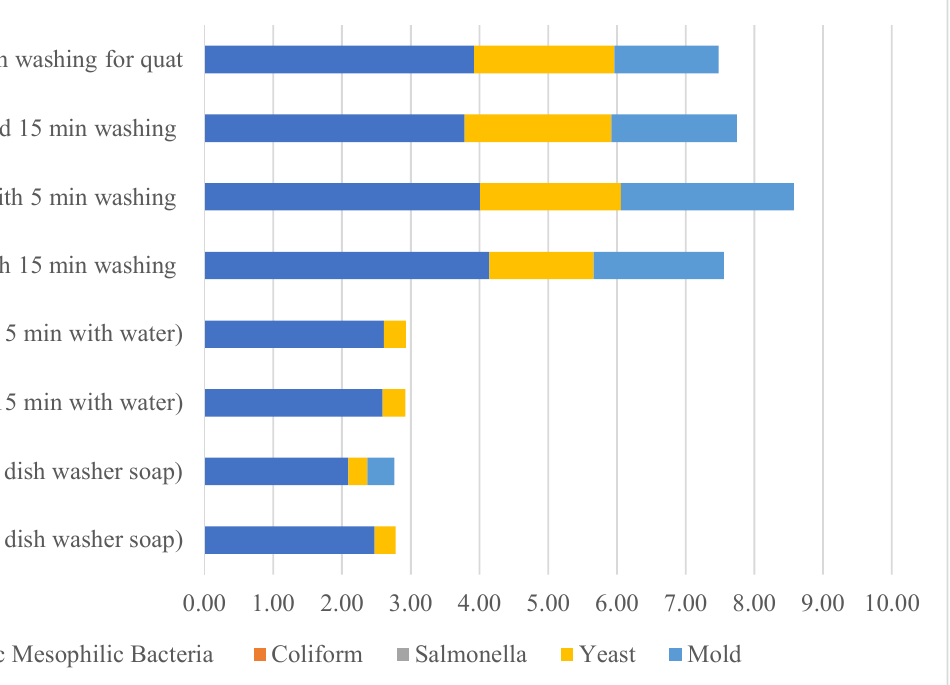
Figure 11. Comparison of the total reduction of microbial load (log CFU/cm 2 ) after washing with quat, distilled water (control) and dishwashing soap (control).